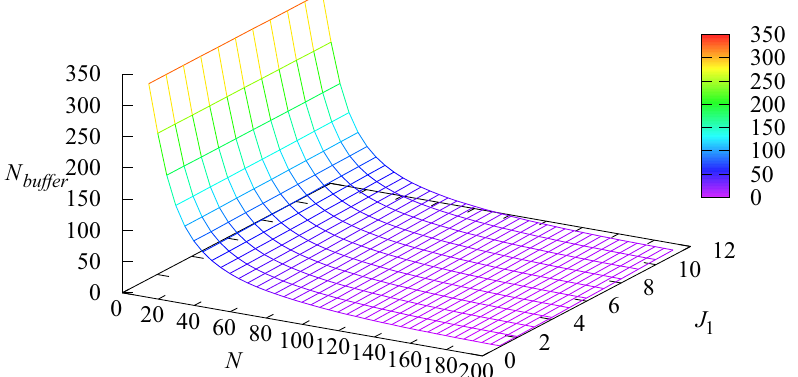
Figure 2. Dependence of the average number of customers in the buffer N buf fer on N and J 1 .